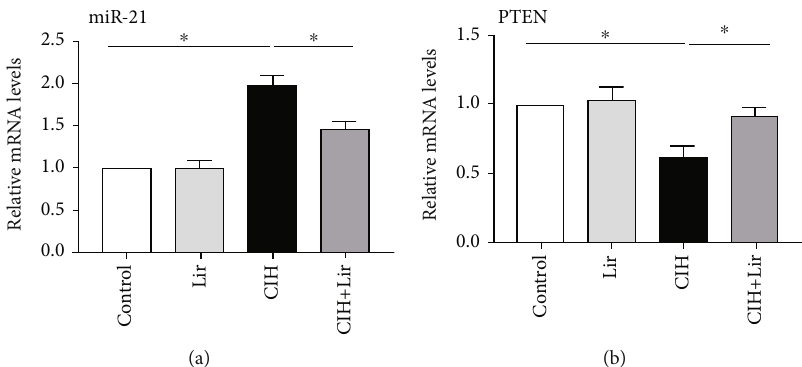
Figure 5: mRNA expression levels determined by real-time fl uorescent quantitative polymerase chain reaction for (a) miRNA-21 and (b) PTEN in four groups ( n = 6 ). Data are mean ± SEM , ∗ P < 0 : 05